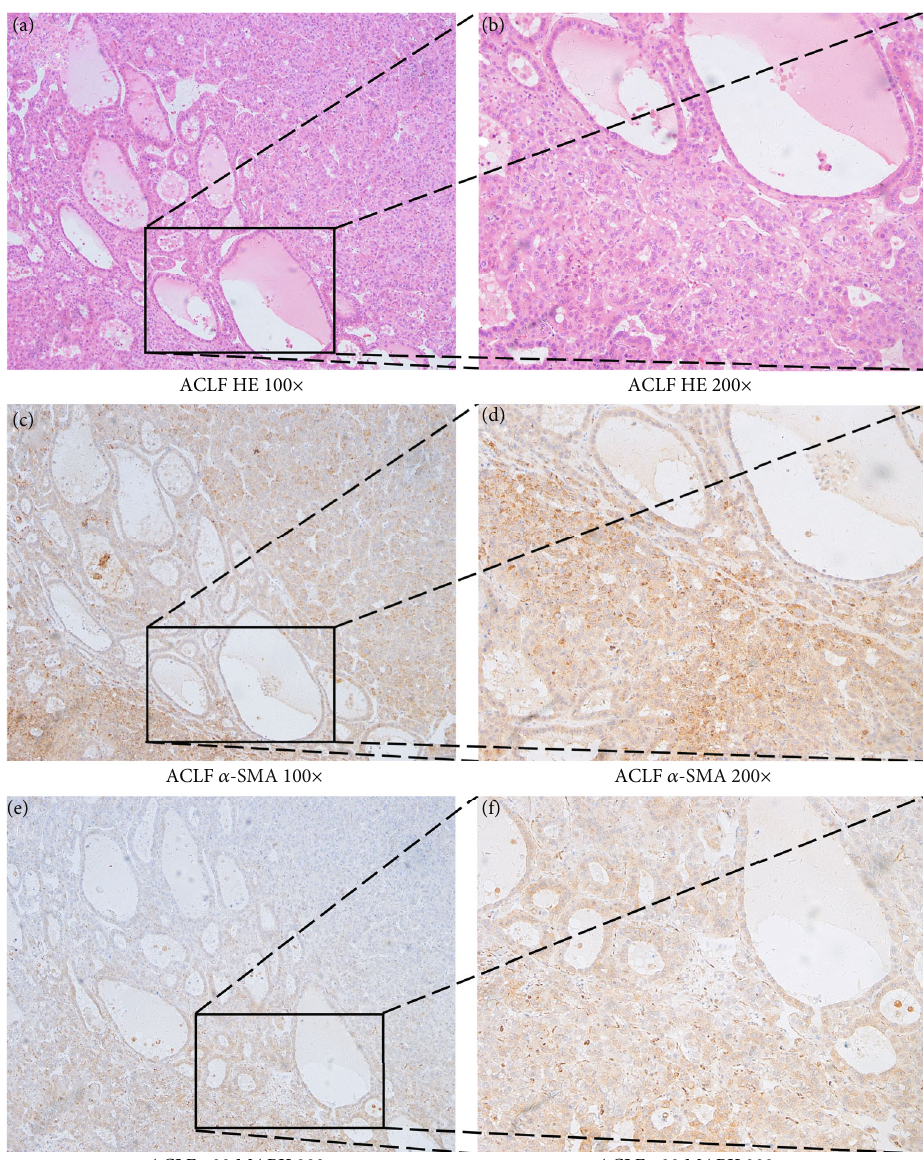
Figure 2: Immunohistochemical staining were conducted in liver tissues from patients with ACLF. The tissues from ACLF patients were fi rstly stained with hematoxylin-eosin (HE) (a, b), then the expression of α -SMA (c, d) and p38 MAPK (e, f). Original magni fi cation 100x (a, c, and e) or 200x (b, d, and